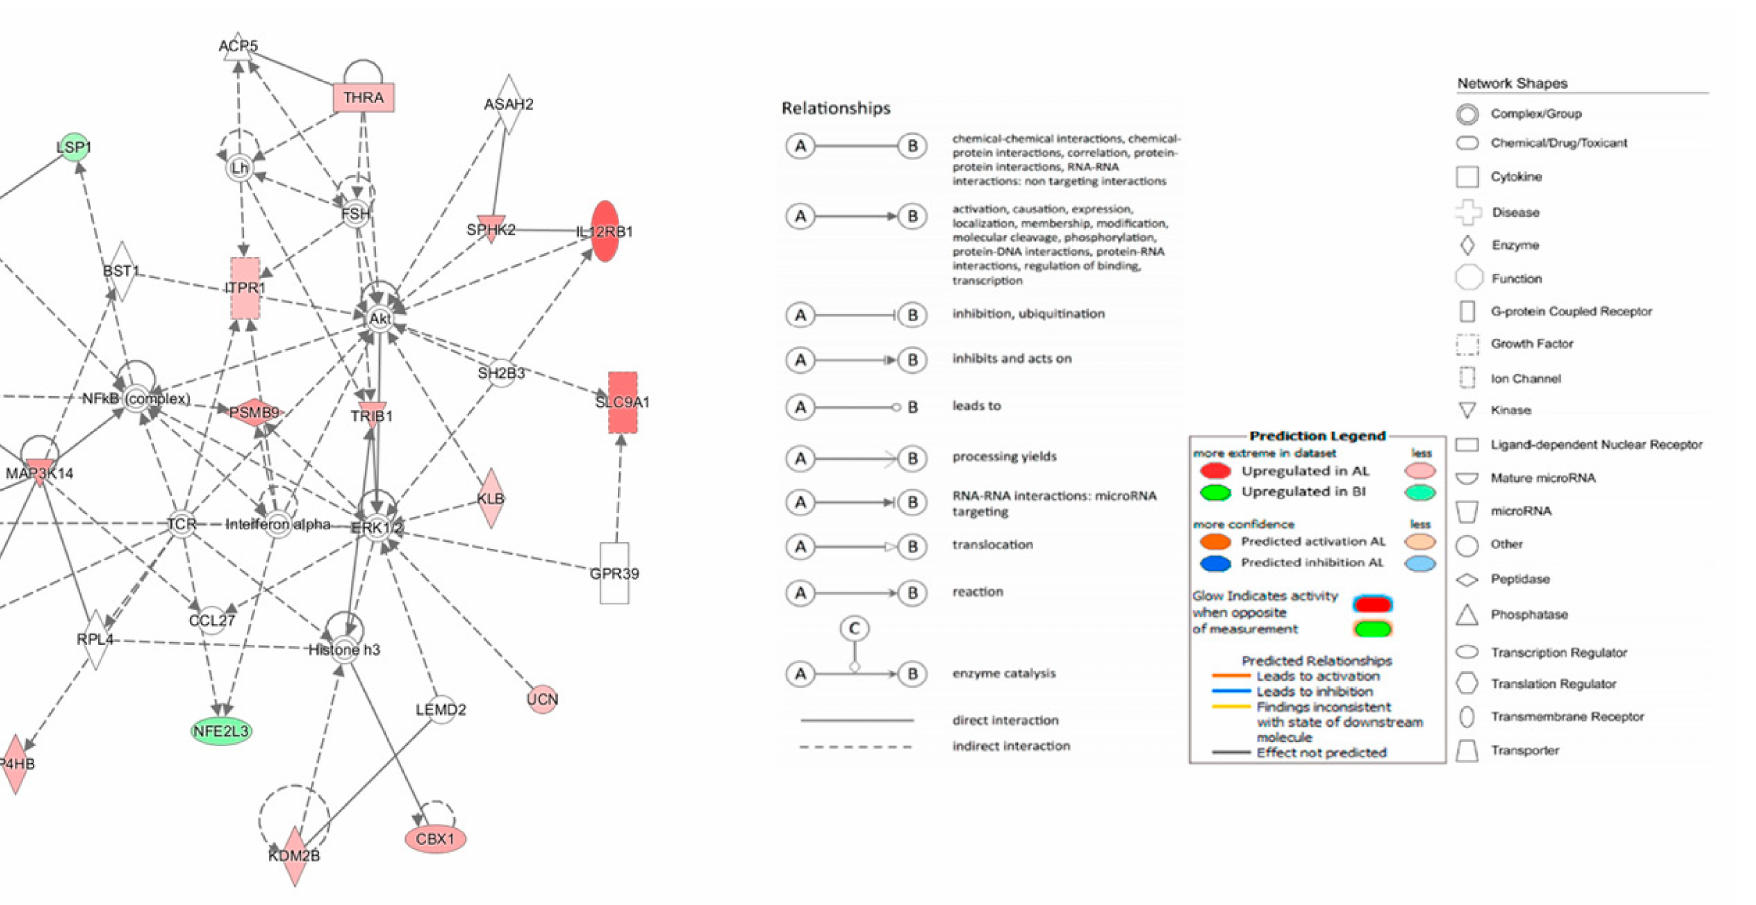
Figure 2. Cellular movement, lipid metabolism and small molecule biochemistry Ingenuity Pathway Analysis (IPA)